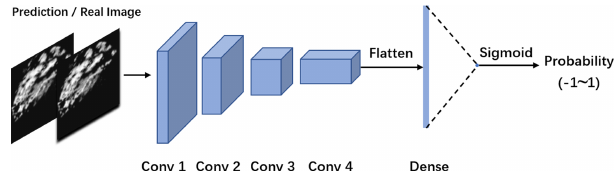
Figure 4. The DC-CNN structure.